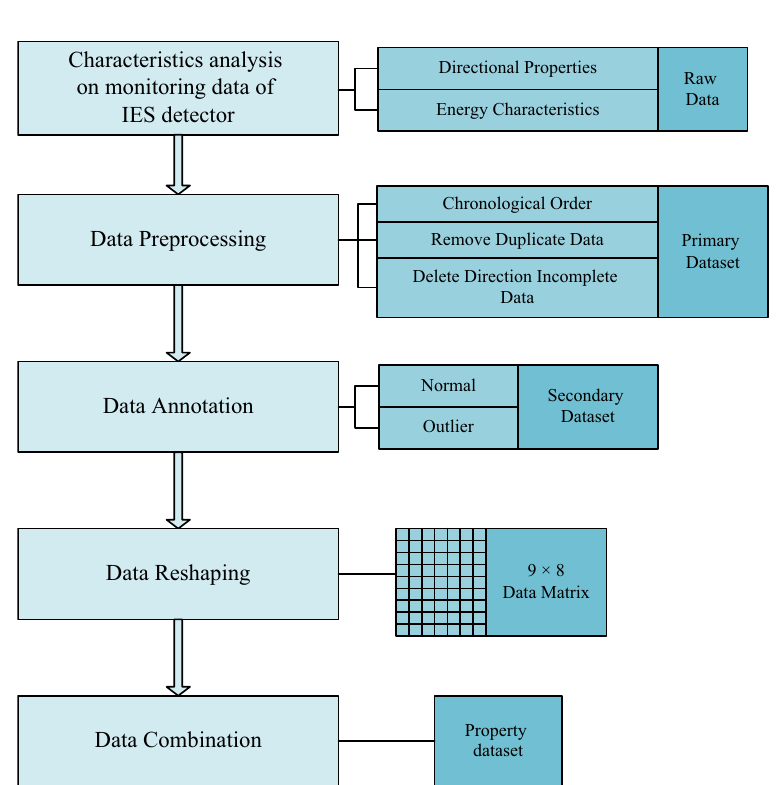
Figure 8: Data processing fl ow